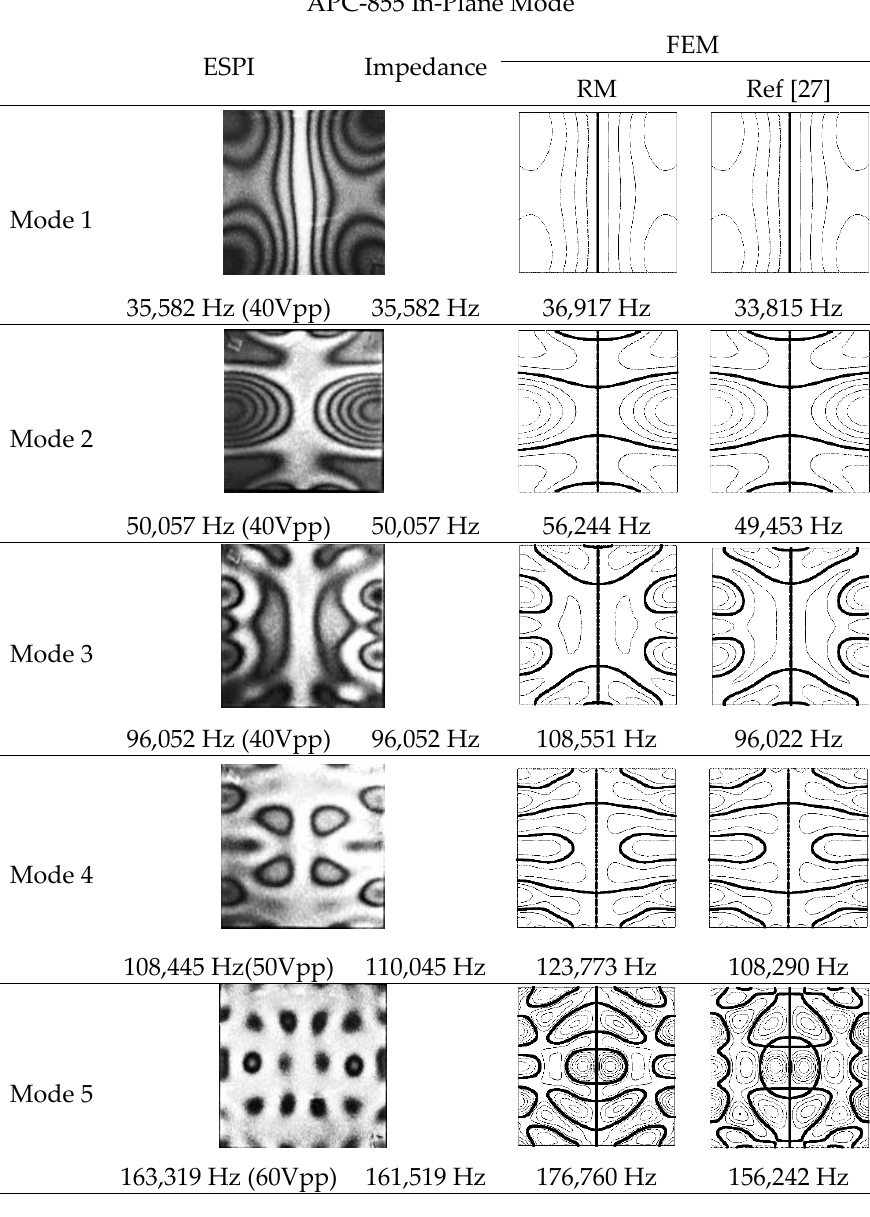
Figure 5. In-plane vibration modes for APC-855, after self heating in resonance.